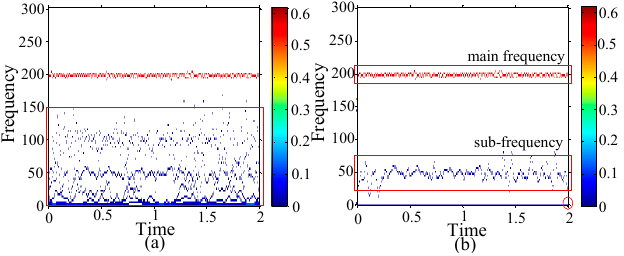
Figure 18. One 0.5 mm hole on inner race ( a ) HHT spectrum ( b ) GEMD-HHT spectrum. (3) One 0.5 mm hole on outer race: